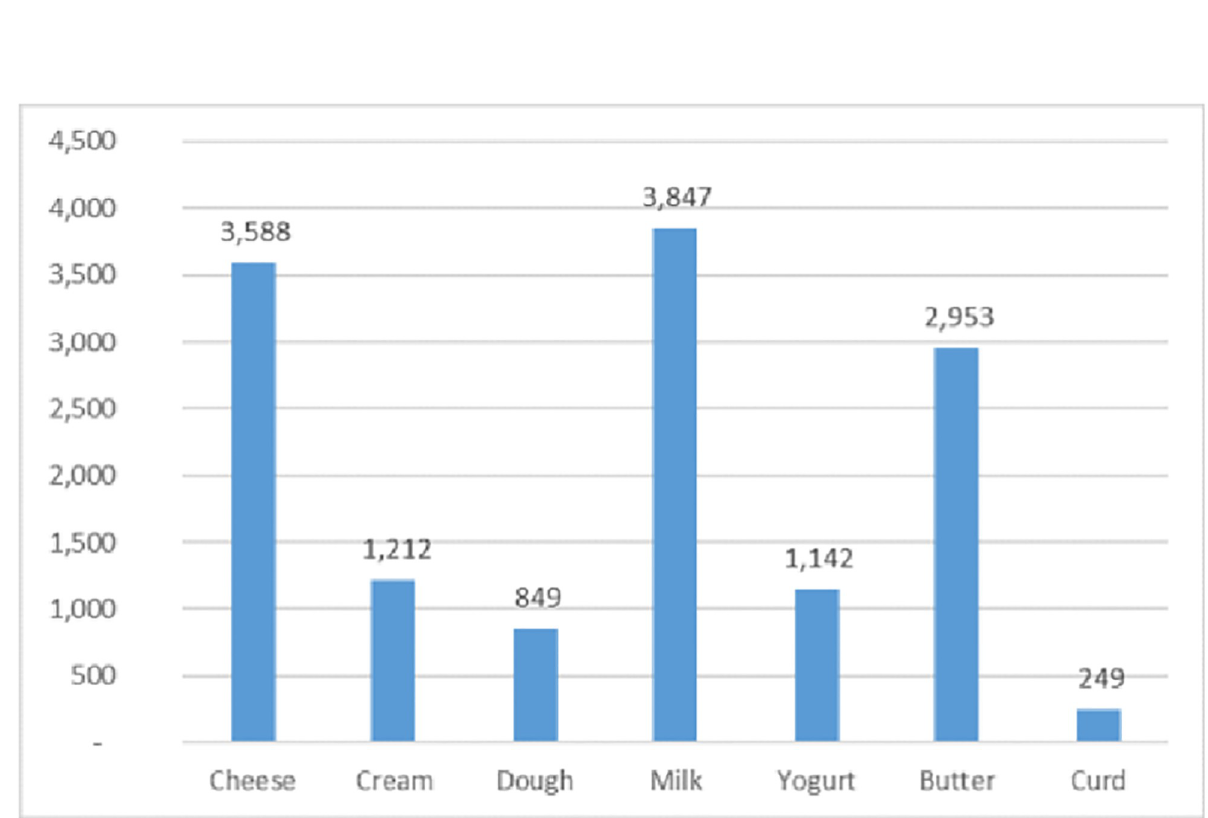
Fig 15. The average inventory for the products in the real problem.